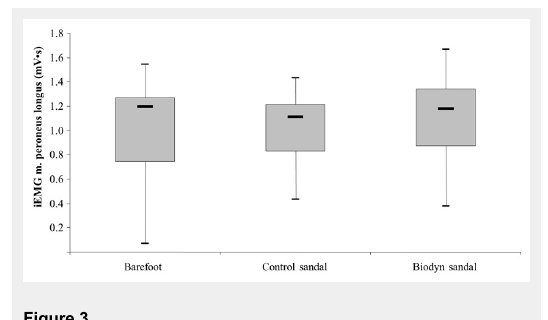
Box plots comparing the coefficient of variation (CV) in step width between testing conditions obtained during walking at a preferred gait